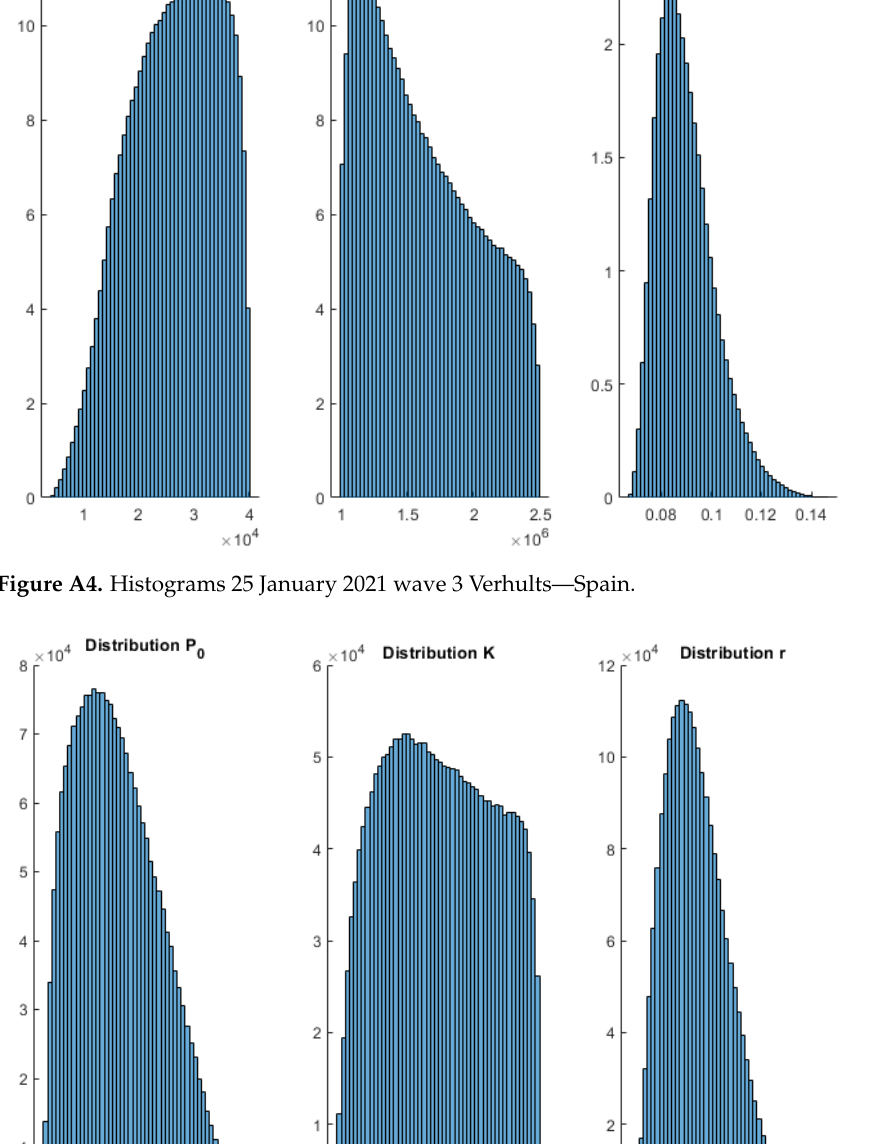
Figure A3. Histograms 5 January 2021 wave 3 SIR — Spain.